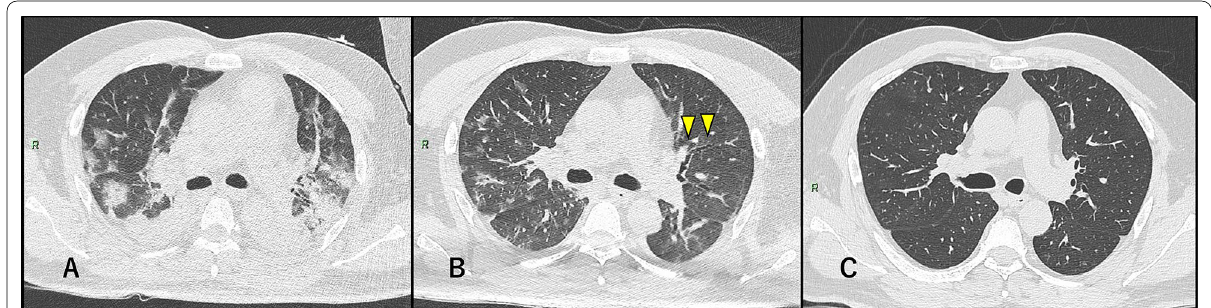
Fig. 1 Severe COVID-19 pneumonia in a 50-year-old man. a At intubation (10 days after symptoms onset): multiple GGO and bilateral, peripheral, and posterior consolidations were observed. b At discharge (22 days after symptoms onset). The consolidation lesions had converted to GGO and remained as diffuse GGO with lower density than in ( a ). Bronchus distortion and bronchial dilatation were also observed. c At 1-month follow-up (50 days after symptoms onset): Most of abnormalities had obviously been